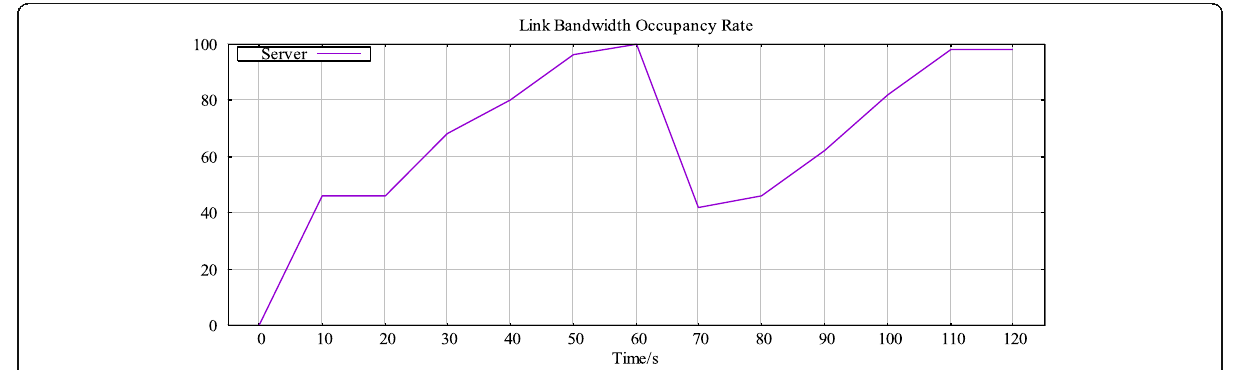
Fig. 5 Cloud link bandwidth occupancy